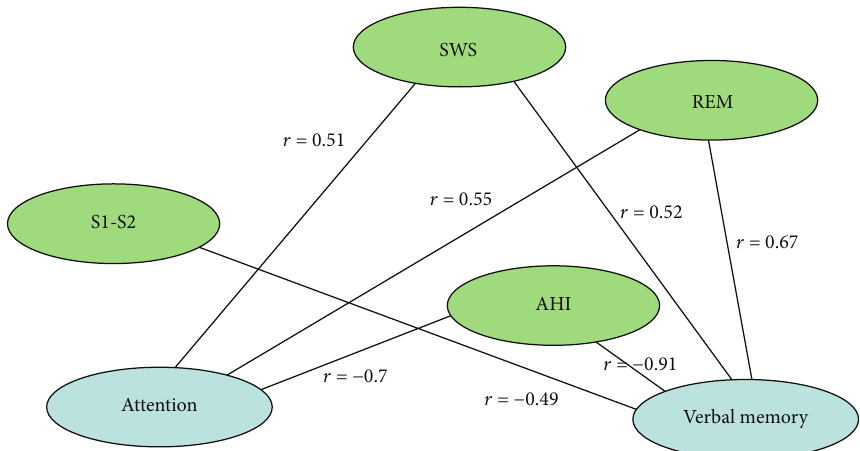
Figure 1: Spearman correlations between sleep parameters and cognitive measures are shown for hypertensive OSA adolescents. As can be seen, very high and statistically significant correlations were found between the verbal memory-AHI ( 𝑟 = −0.91 , 𝑃 < 0.05 ), the verbal memory-REM ( 𝑟 = 0.67 , 𝑃 < 0.05 ), and the attention-AHI ( 𝑟 = −0.7 , 𝑃 < 0.05 ).